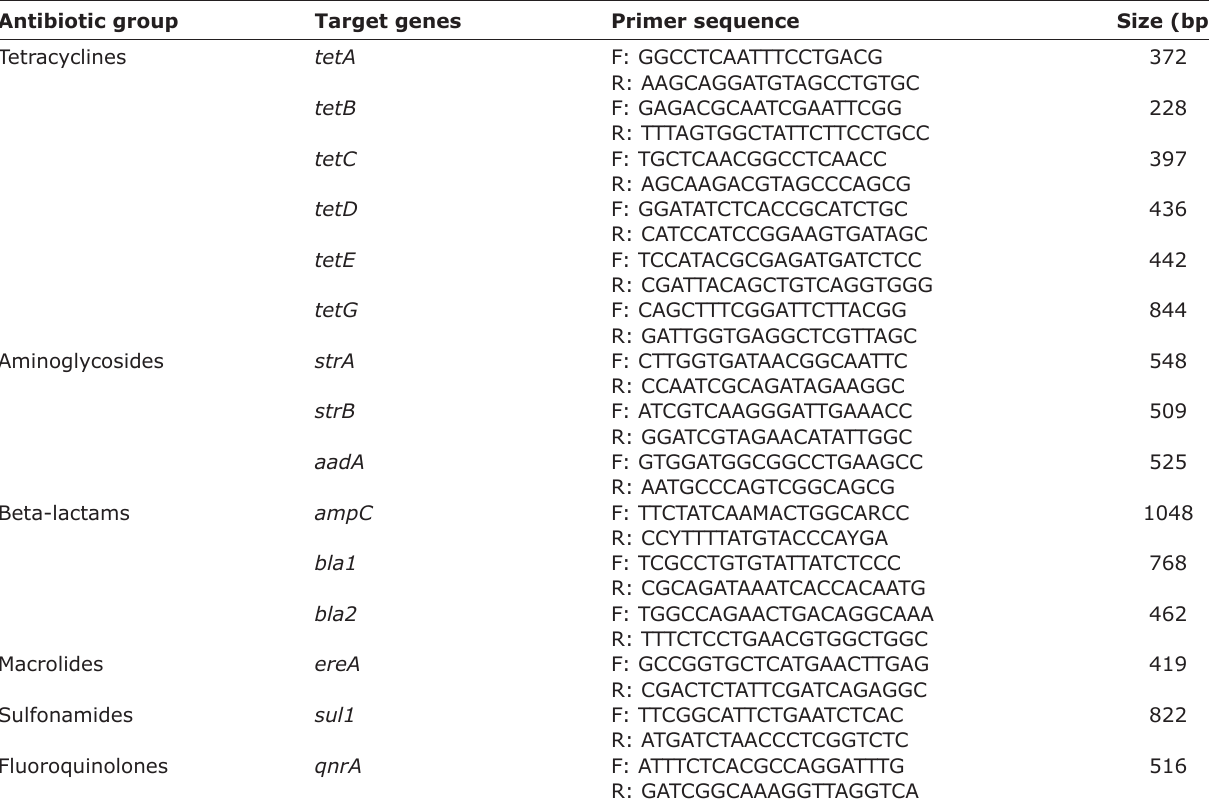
Table-1: Oligonucleotide primers used to detect antimicrobial resistance genes.